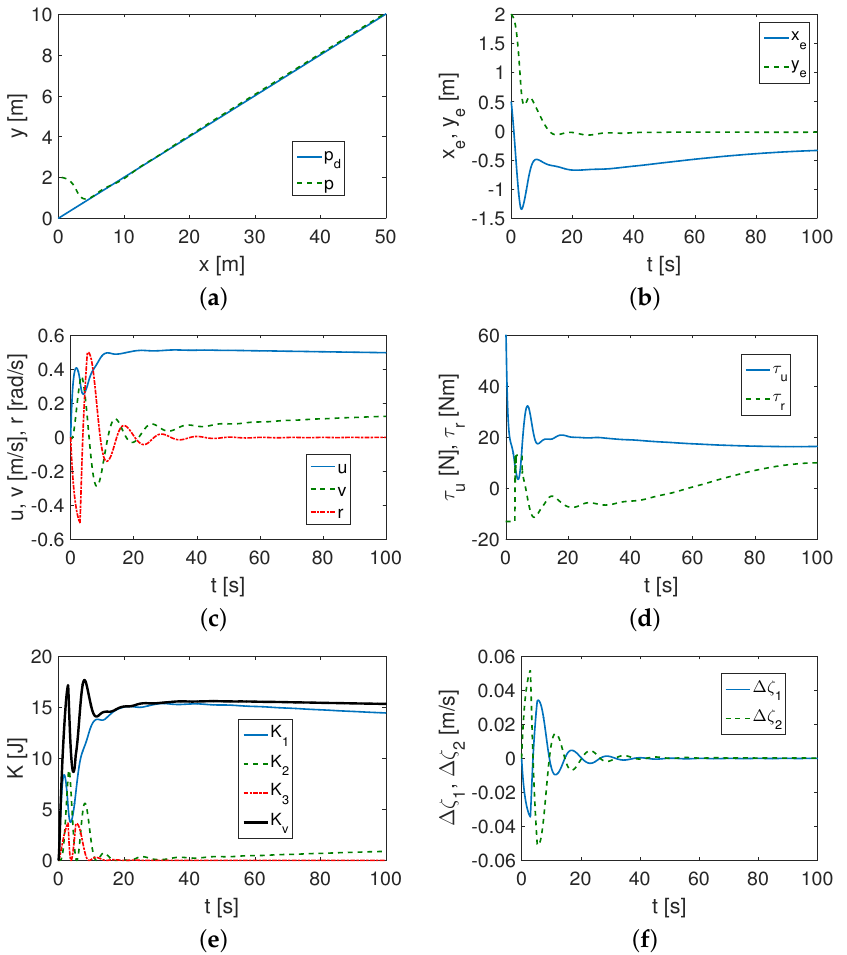
Figure 7. Results for the CETUS II, QV controller and linear trajectory: ( a ) desired and realized trajectory; ( b ) position errors; ( c ) velocity errors; ( d ) applied force and torque; ( e ) kinetic energy time history; ( f ) quasi-velocity errors ∆ ζ 1 , ∆ ζ 2